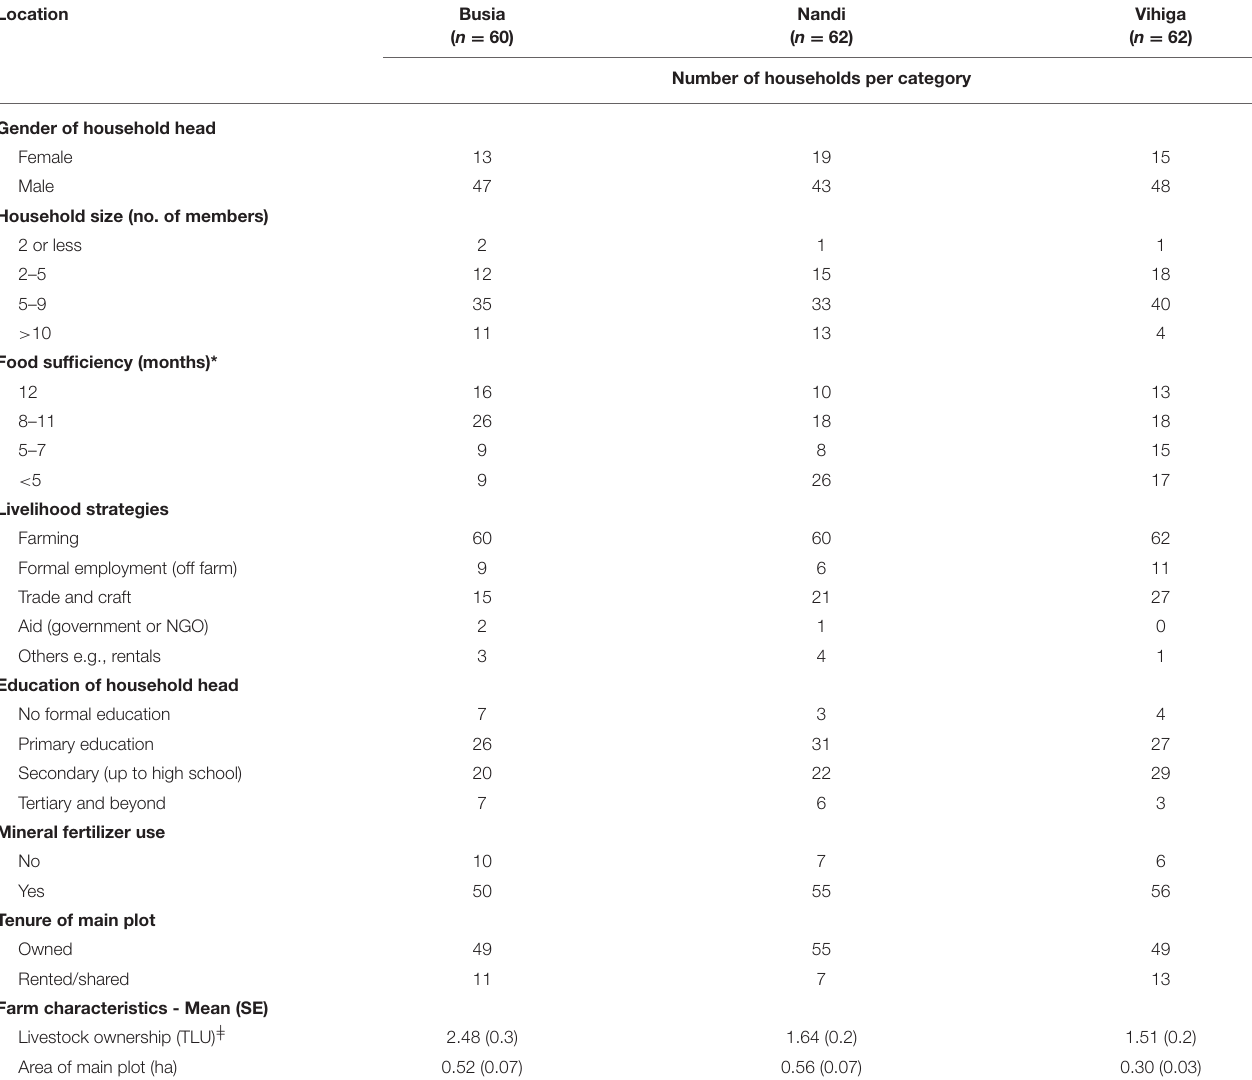
TABLE 3 | Household demographic information and farm characteristics of smallholder farmers interviewed in Nandi, Busia, and Vihiga counties in western Kenya in June 2019.